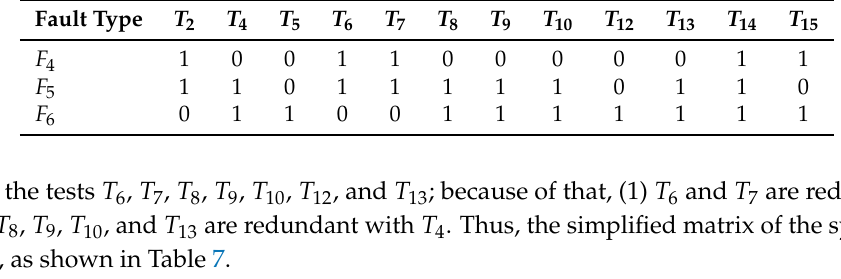
Table 6. Simplified dependency matrix of the case study in Experiment 1.